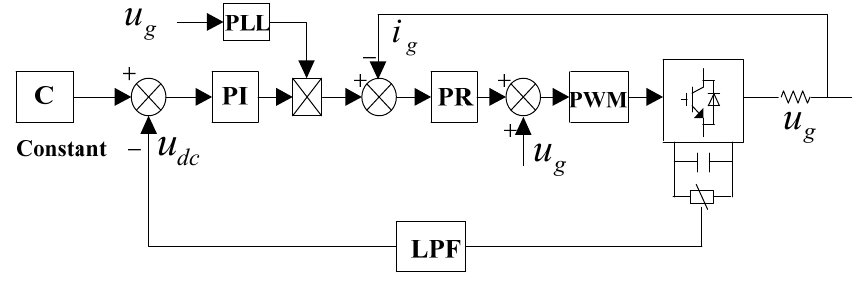
Figure 4. The improved bi-directional DC-AC control strategy of grid-side